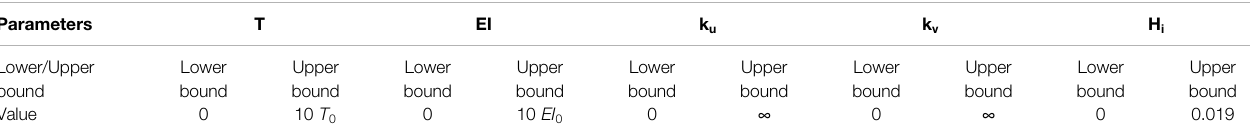
TABLE 9 | Solution range when solving optimization problem in experimental veri fi cation ( T 0 , tension measured by load cell in Table 5(c); EI 0 , design value in catalog listed in Table 5(a)).